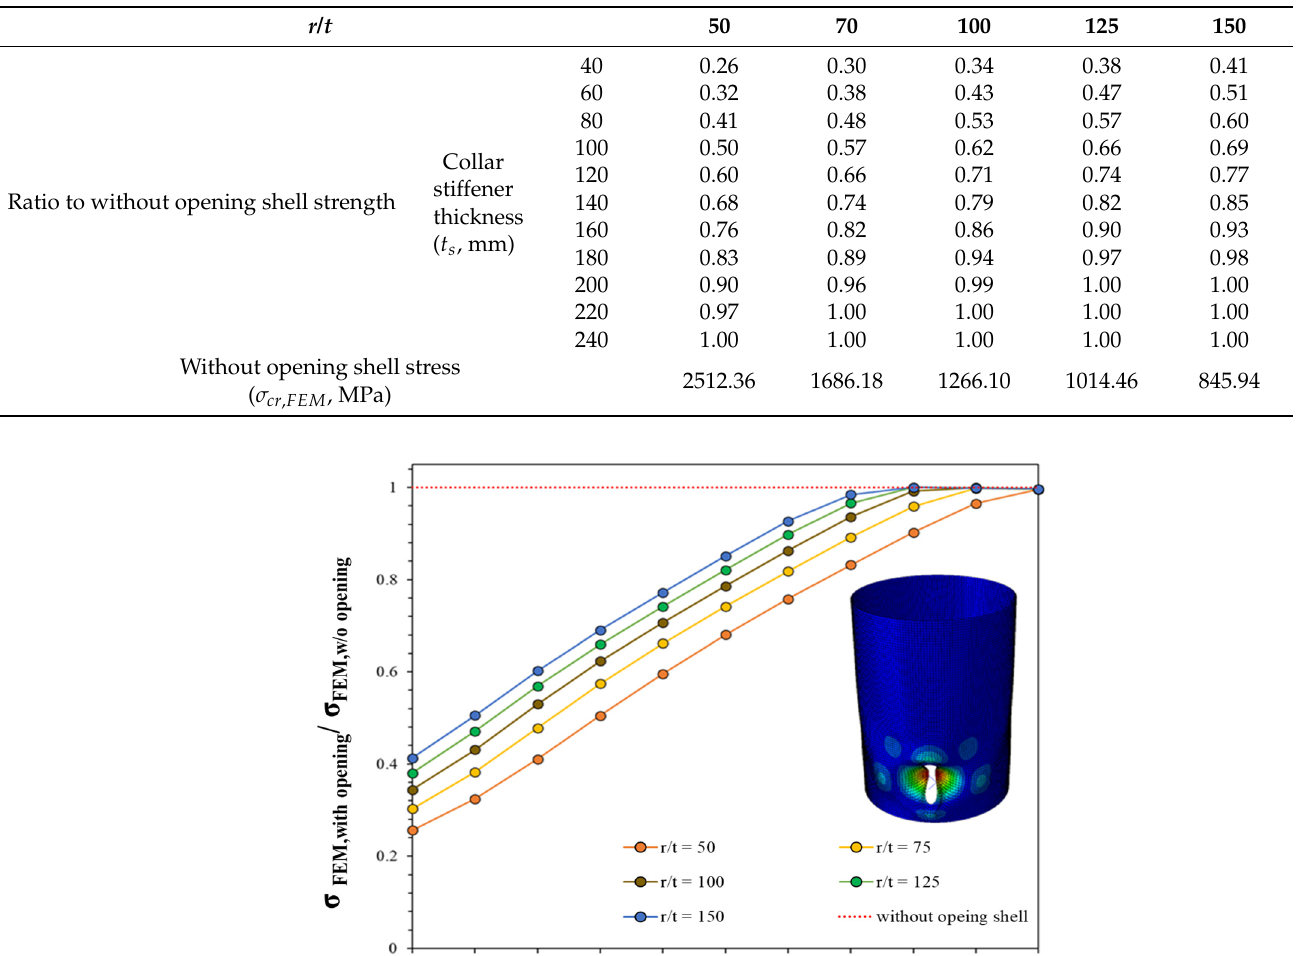
Table 7. Comparison of linear buckling analysis results by parameter.